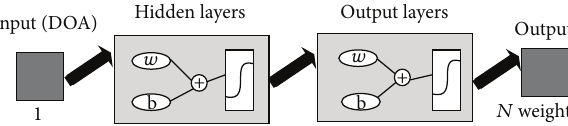
Figure 5: Neural Network block diagram